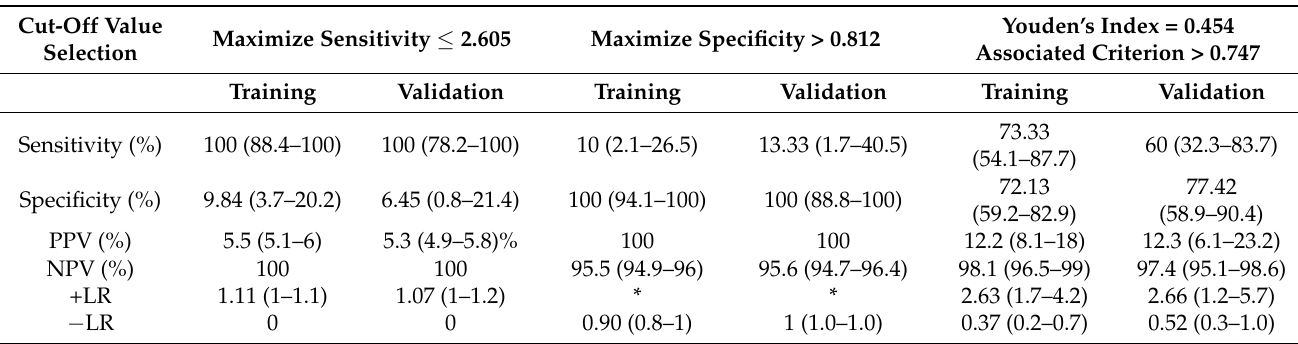
Table A5. Cut-off model. The criteria for choosing values of cut-off points in the training cohort were represented by maximizing either sensitivity or specificity or according to the Youden’s Index criteria.